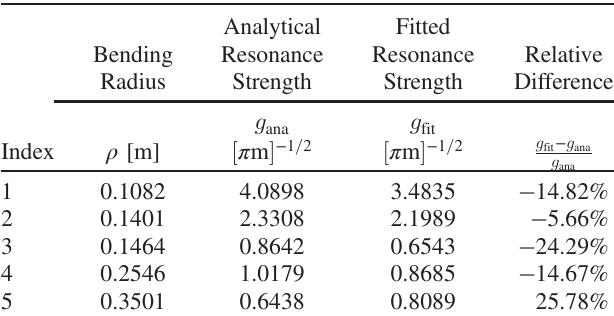
.TABLE II. Comparison of the resonance strength g 3 calculated by analytical method ( g ( g ) in different bending radii ρ fit